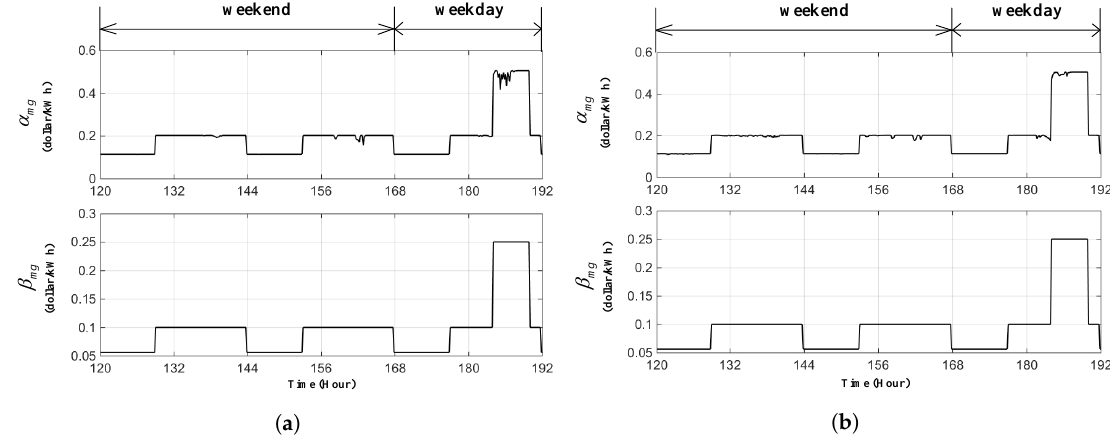
Figure 8. Weekend dynamic electricity prices: ( a ) without dissipativity based coordination; ( b ) with dissipativity based